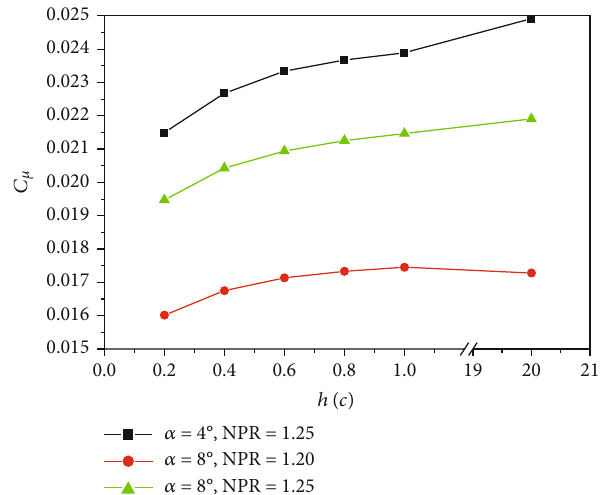
Figure 9: Curves of jet momentum coe ffi cient versus ride height.